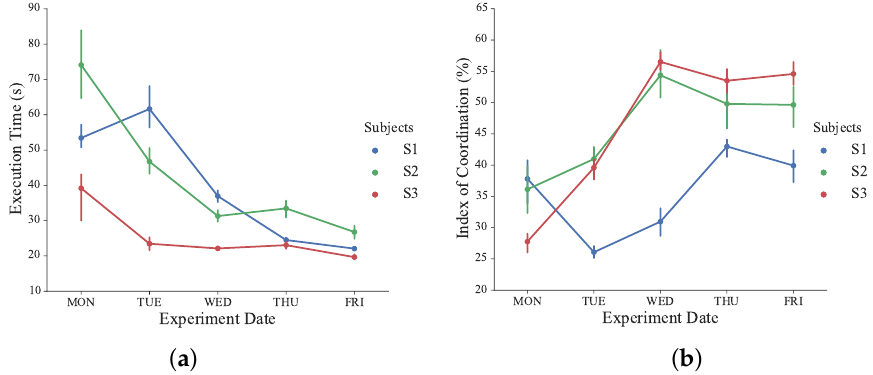
Figure 16. ( a ) Execution time of all subjects during the learning phase; ( b ) The index of coordination of all subjects during the learning